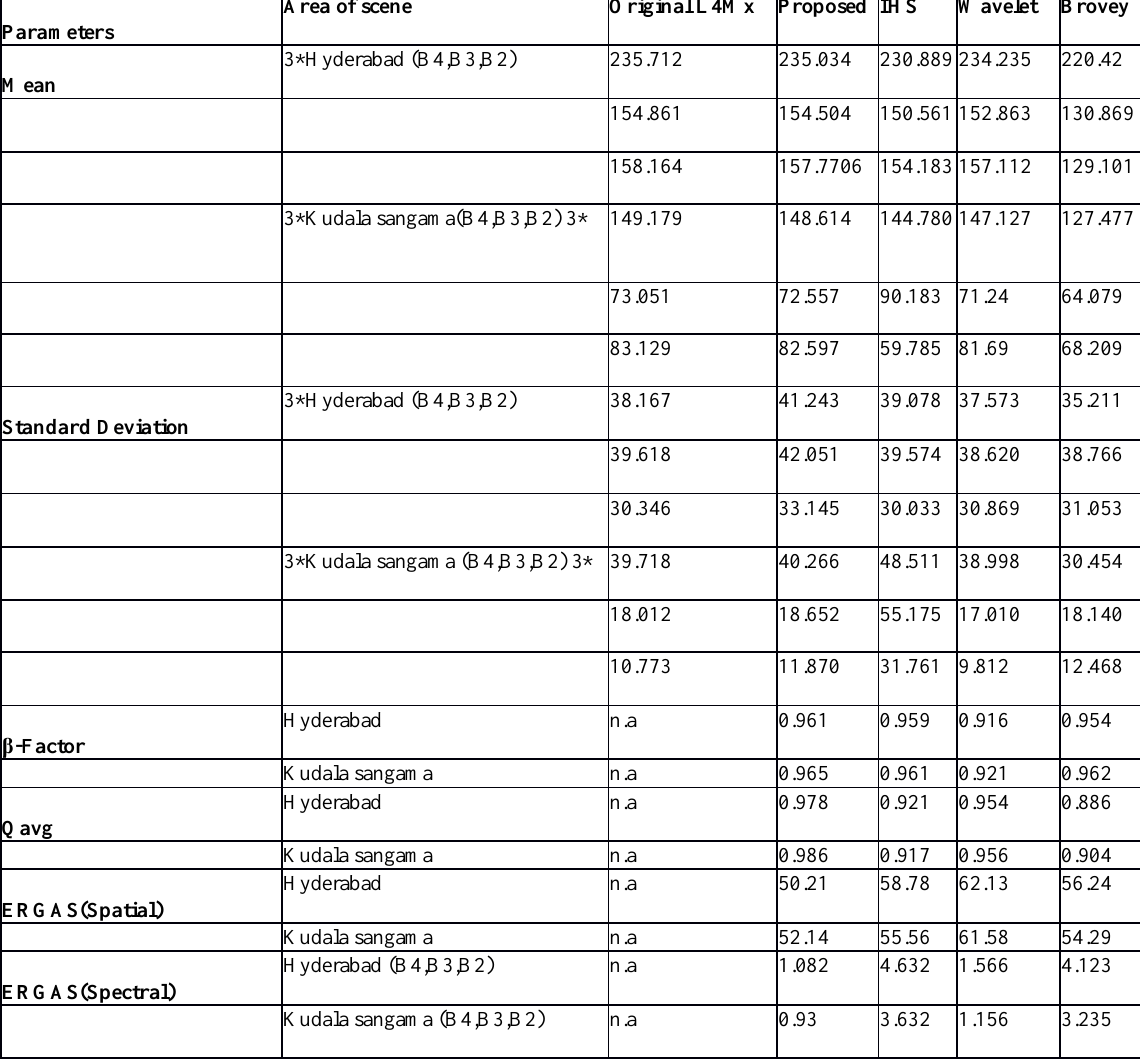
Table 3: Quantitative results of Fused